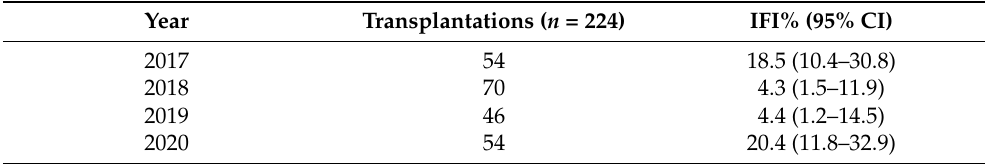
Table 5. Transplantations and invasive fungal infections per